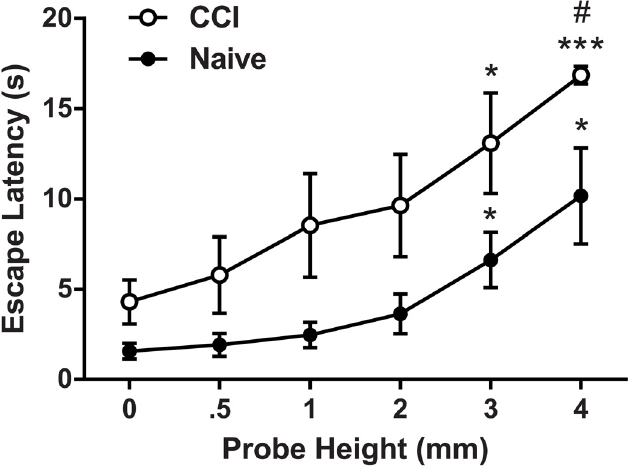
Fig 2. Stimulus response relationship of latency to escape the light compartment as a function of probe height between naive and CCI rats (n = 7 per group). As probe height increases, escape latency also increases in both experimental groups. Escape latencies of CCI rats are greater than those of naive controls. # p < .05 between groups; * p < .05 compared to 0 mm; *** p < .001 compared to 0